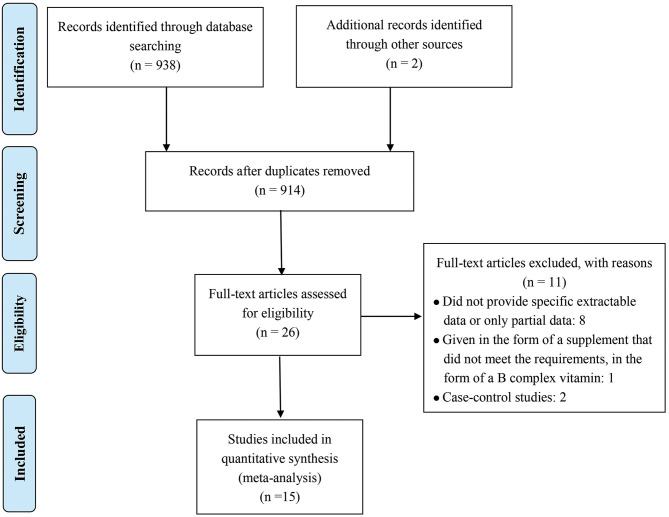
Flow diagram of study selection process.